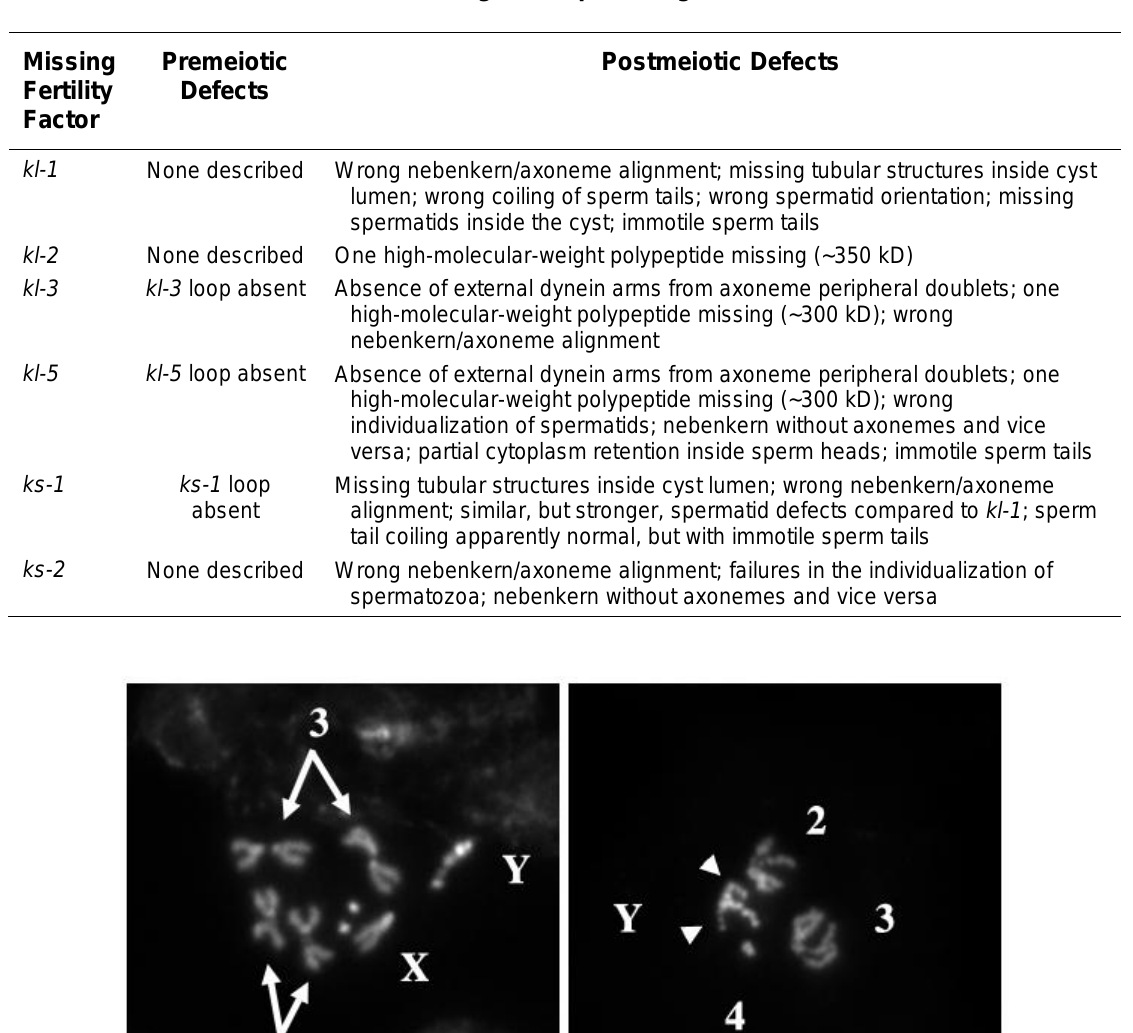
Fertility Factors Missing from the Y Chromosome and Corresponding Abnormal Phenotypes in D. melanogaster Spermatogenesis